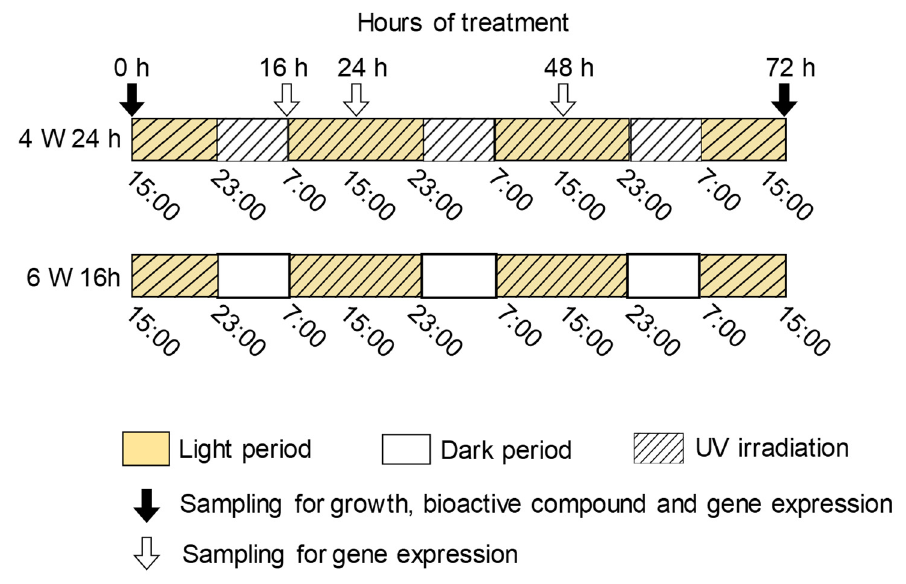
Figure 3. A schematic representation of UV-B sampling and exposure times (experiment 2. The plants were subjected to UV-B irradiation at 4 W m − 2 with continuous irradiation (4 W 24 h) and 6 W m − 2 with 16 h irradiation (6 W 16 h). Sampling was conducted at 0, 16, 24, 48, and 72 h for the analysis of time-dependent responses to UV-B irradiation.